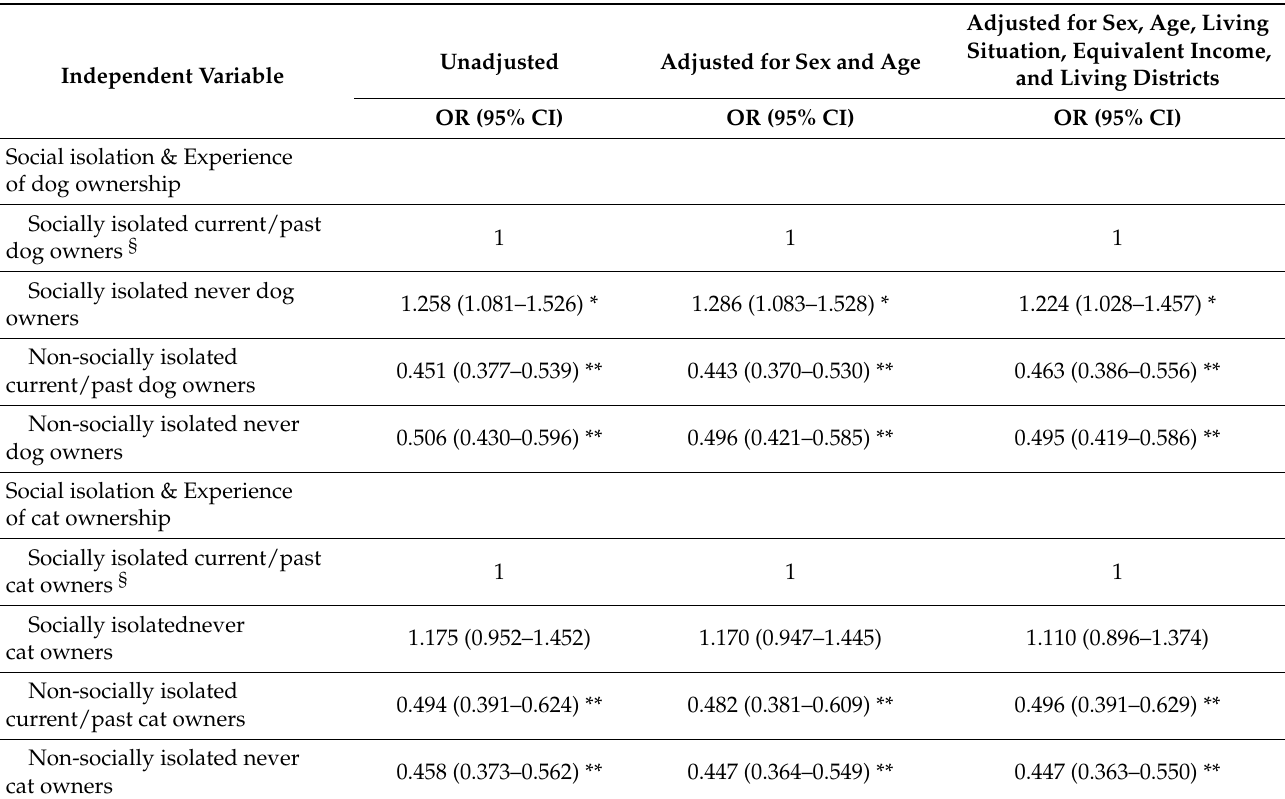
Table 3. Independent associations of social isolation and experience of dog/cat ownership with lower psychological health among 9856 community-dwelling older